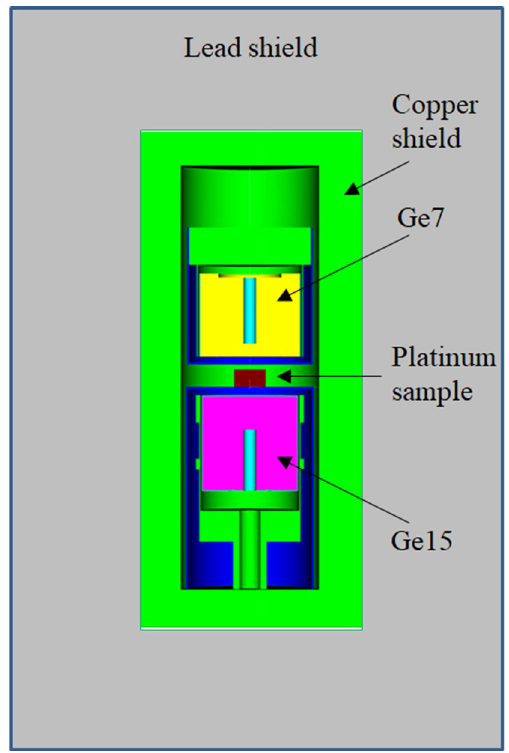
Fig. 3 Schematicoftheexperimentalultralow-backgroundset-upwith the HPGe detectors and the platinum sample